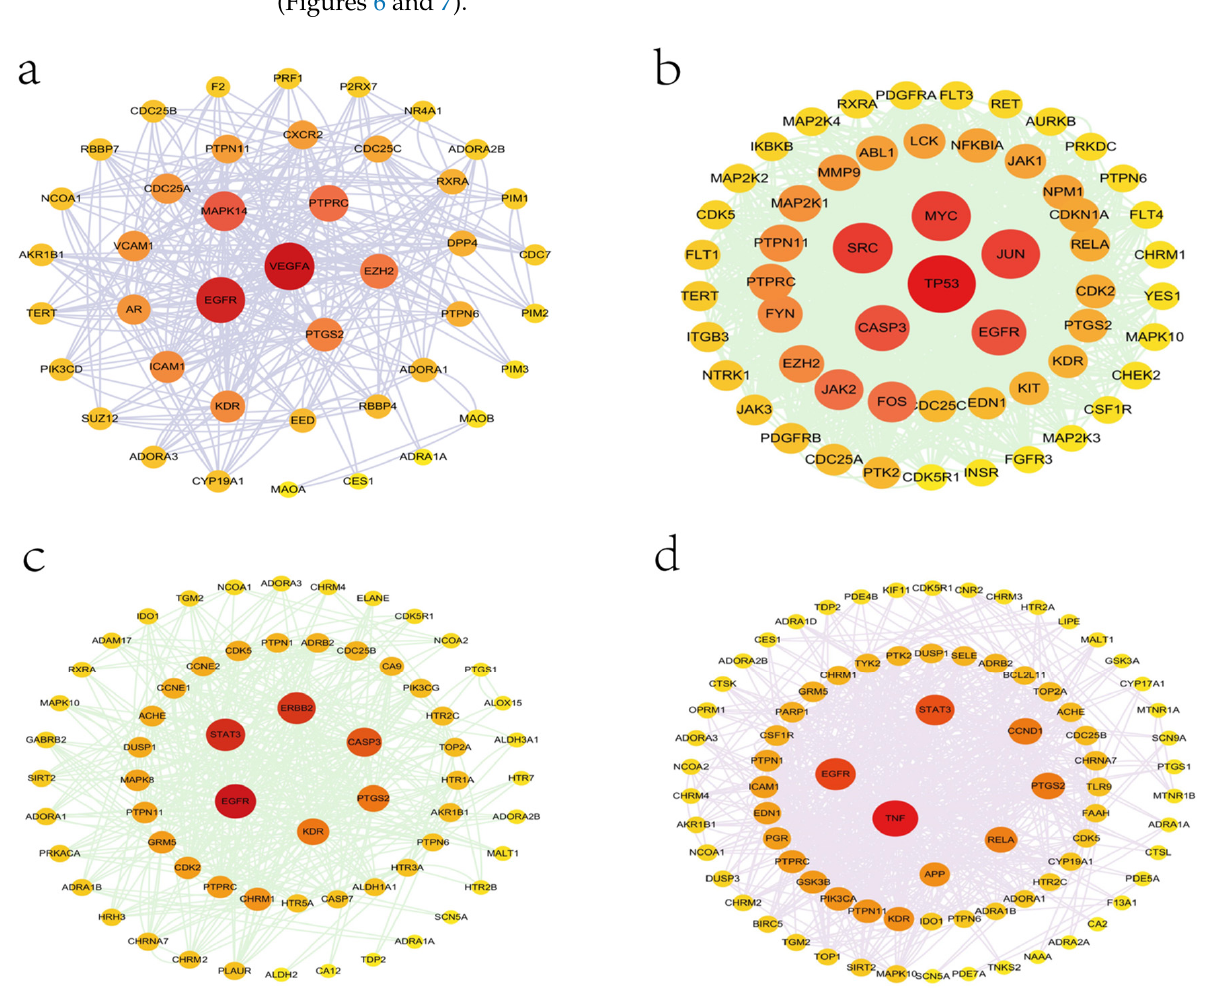
Figure 5. Protein network analysis of four Tanshinone components (( a ): Tanshinone Ir; ( b ): Tanshinone IIA; ( c ): Dihydrotanshinone I; ( d ): Cryptotanshinone).